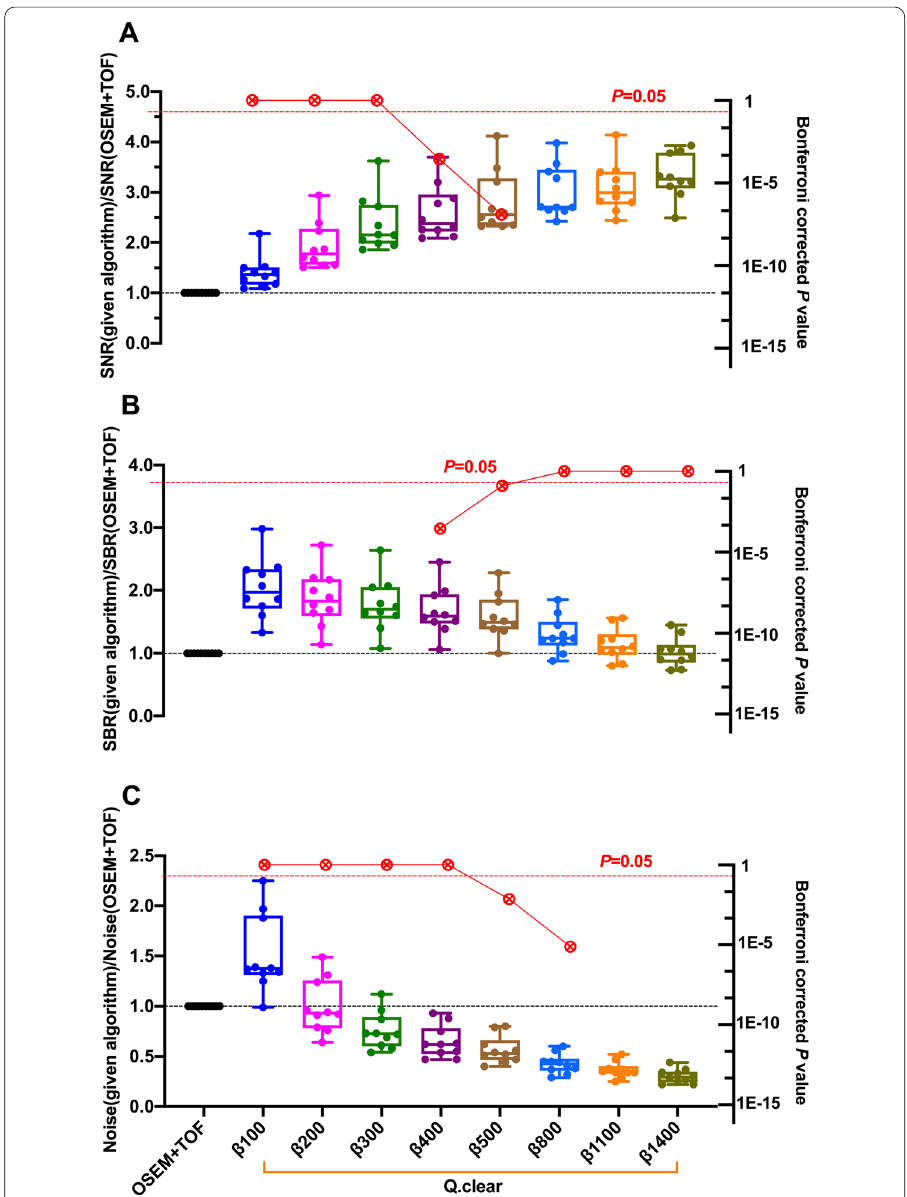
The lines, upper and lower halves of the box represent the median, upper and lower quartiles, respectively. Bonferroni corrected P values between OSEM TOF and a given algorithm (Q.Clear with specific β value) + were also presented in red circles (right Y